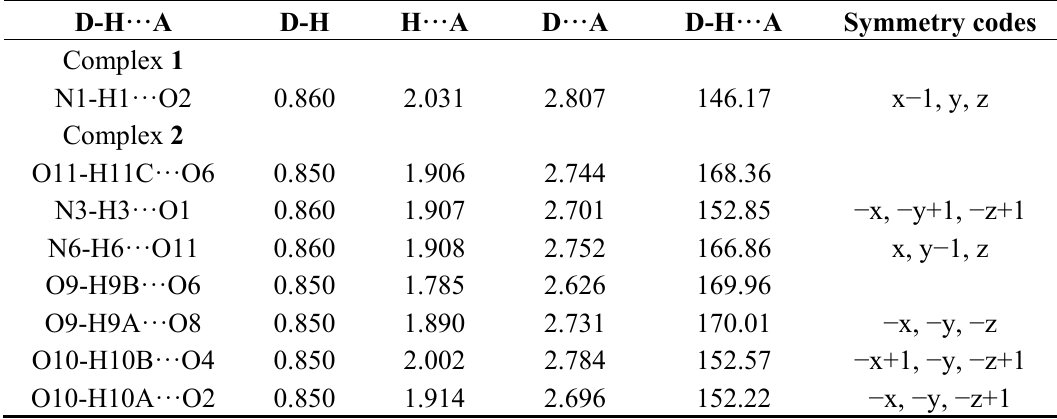
Table 3. Hydrogen-bond geometry (Å) for